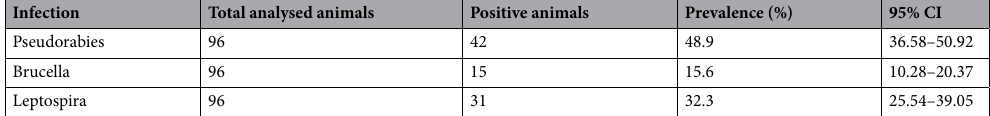
Table 1. Number of positive animals and prevalence of Pseudorabies, Brucella and Leptospira in the 96 animals collected from Tuscany